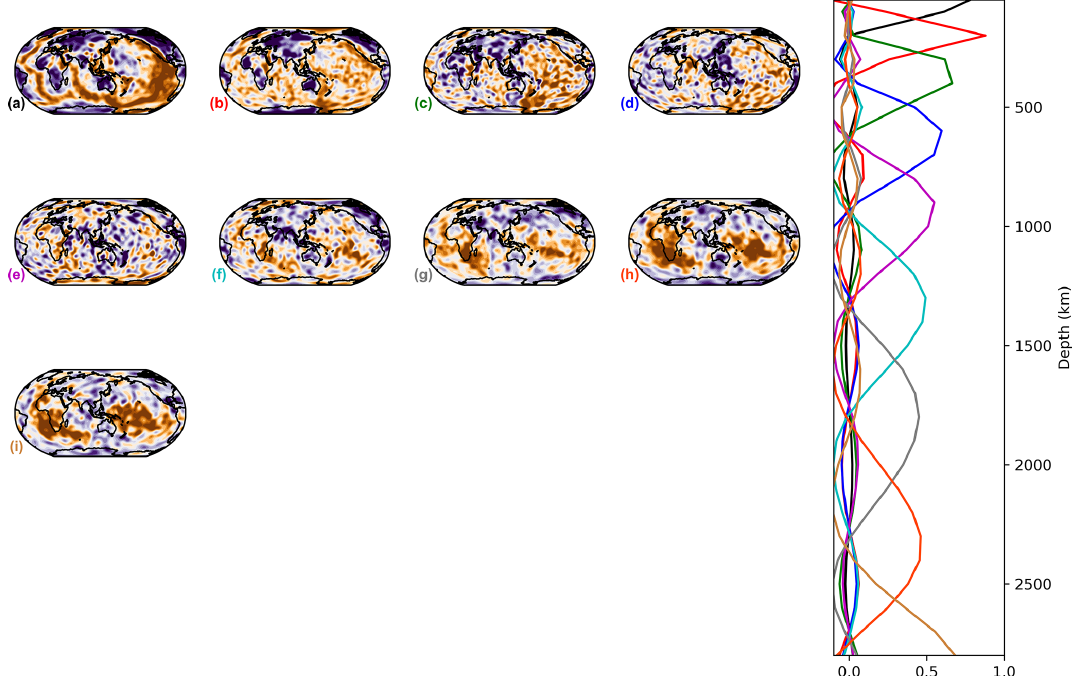
Figure 4. The nine varimax components of the SEMUCB − WM1i model. On the right are the principal components or vertical profiles, and on the left are the associated horizontal structures. The other models are shown in the Appendix in Figs.